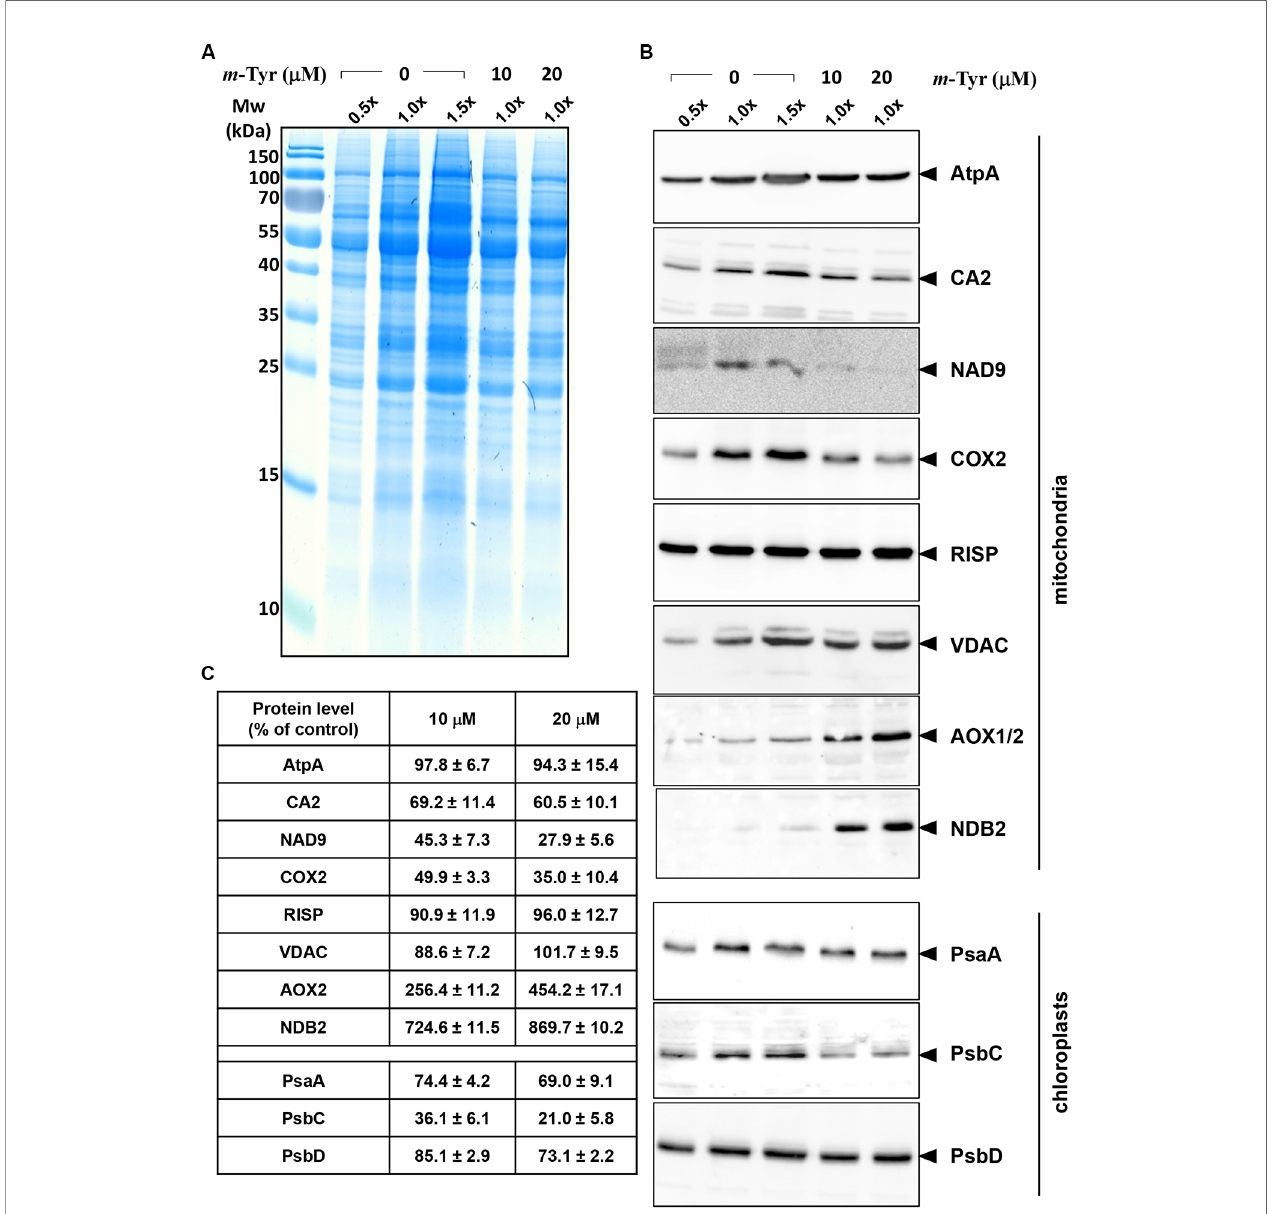
FIGURE 5 | Relative accumulation of organellar proteins in 5-day-old Arabidopsis plants grown in the absence or presence of m -tyrosine. Immunoblot analyses of 5-day-old Arabidopsis thaliana (Col-0) plants grown in the absence or presence of m -tyrosine. For the quanti fi cation of the relative abundances of organellar proteins in the plants, different amounts of total proteins extracted from control (untreated) and m -tyrosine-grown seedlings were loaded and separated by sodium dodecyl sulfate polyacrylamide gel electrophoresis (SDS-PAGE). After electrophoresis, the gel was stained with Coomassie Blue (A) , or transferred to a PVDF membrane for immunobloting (B) . The blots were probed with polyclonal antibodies raised to different organellar proteins (see Table S1 ), as indicated in the right panel. Detection was carried out by chemiluminescence assays after incubation with horseradish peroxidase (HRP)-conjugated secondary antibody. These include the mitochondrial proteins, ATP-synthase subunit 1 (AtpA), subunit CA2 of complex I ( g -type carbonic anhydrase-like subunit 2) (Perales et al., 2005), and NADH dehydrogenase subunit 9 (NAD9) (Lamattina et al., 1993), the Rieske iron-sulfur protein (RISP) of complex III (cytochrome c reductase) (Carrie et al., 2010), cytochrome oxidase subunit 2 (COX2) of complex IV (C-IV), alternative oxidase (AOX1a) (Elthon et al., 1989), the external NADH-dehydrogenase subunit 2 (NDB2) (Carrie et al., 2008), and the voltage-dependent anion channel (VDAC, or Porin), and the plastidial Photosystem I P700 chlorophyll a apoprotein A1 (PsaA), photosystem II CP43 reaction center protein (PsbC), and photosystem II D2 protein (PsbD). Arrows in the blots indicate to AtpA (55 kDa), CA2 (28 kDa), NAD9 (23 kDa), COX2 (30 kDa), RISP (23 kDa), VDAC (29 kDa), AOX1/2 (36 kDa), NDB2 (50 kDa), PsaA (52 kDa), PsbC (43 kDa), PsbD (39 kDa). Hybridization signals were analyzed by chemiluminescence assays after incubation with HRP-conjugated secondary antibody. The intensities of protein signals in panel B were evaluated using the ImageJ software (Jensen, 2013). The data shows the relative accumulation of each protein in untreated versus m -tyrosine-treated seedlings (panel C ). The values are means of three biological replicates ±